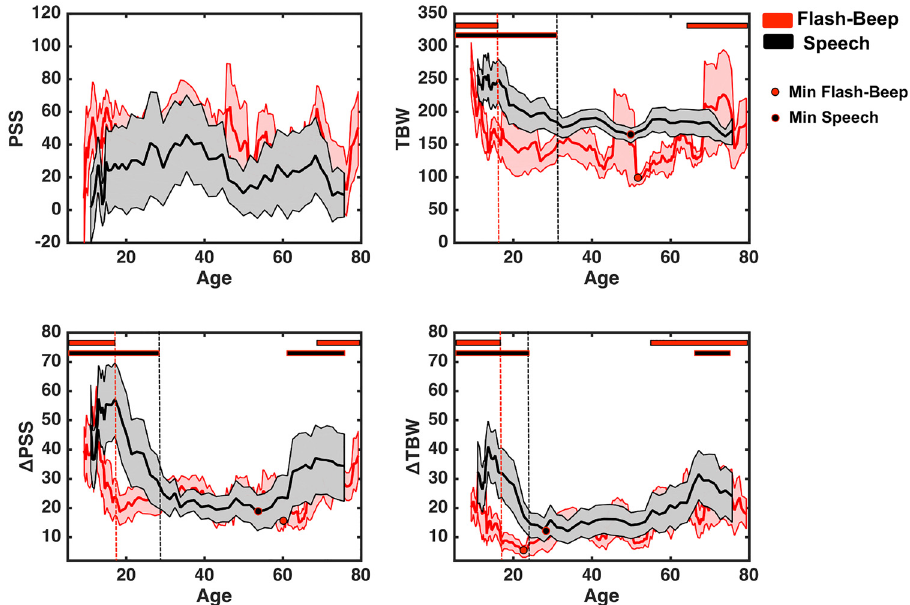
Fig 2. Simultaneity judgment and rapid recalibration as a function of stimuli complexity and age. Although no change is apparent in PSS (upper left), temporal window of simultaneities for both Flash-Beep (red) and Speech (black) stimuli portray protracted developmental time-courses (upper right). Similarly, rapid recalibration effects, both in terms of change in PSS (lower left) and TWS (lower right) as a function of the nature of the immediately precedent trial follow protracted developmental time-course, and a U-shape, indexing greater tendency to rely on recent perceptual experience later in life. Solid lines represent the mean of the 11-participant wide window centered at the particular age, shaded areas around the solid lines represent +/- 1 S.E.M. Dashed vertical lines represent the first age-point at which within condition values differed from the first time-point (thus, age at which the particular perceptual process reached maturity). The colored circles represent the minimum value for either the raw TWS or the change in PSS or TWS as a function of age. And finally the solid horizontal lines at the top of the panels indicate significant differences (p < 0.05) from the minimal value (circle). Hence, if these solid horizontal lines are present both at earlier and later ages than the respective minimum, we categorize the particular time-course as being